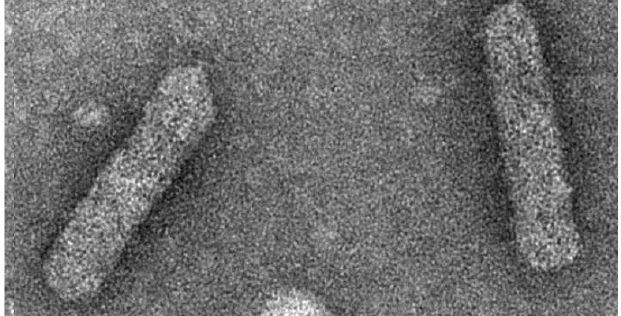
Figure 1. Electron micrograph of Kalanchoe top spotting virus , Badnavirus , Caulimoviridae. Crude sap preparation from infected Kalanchoe, negatively stained with 1% uranyl acetate. Photo: K. Richert-Pöggeler, copyright: Julius Kühn-Institut, Braunschweig.